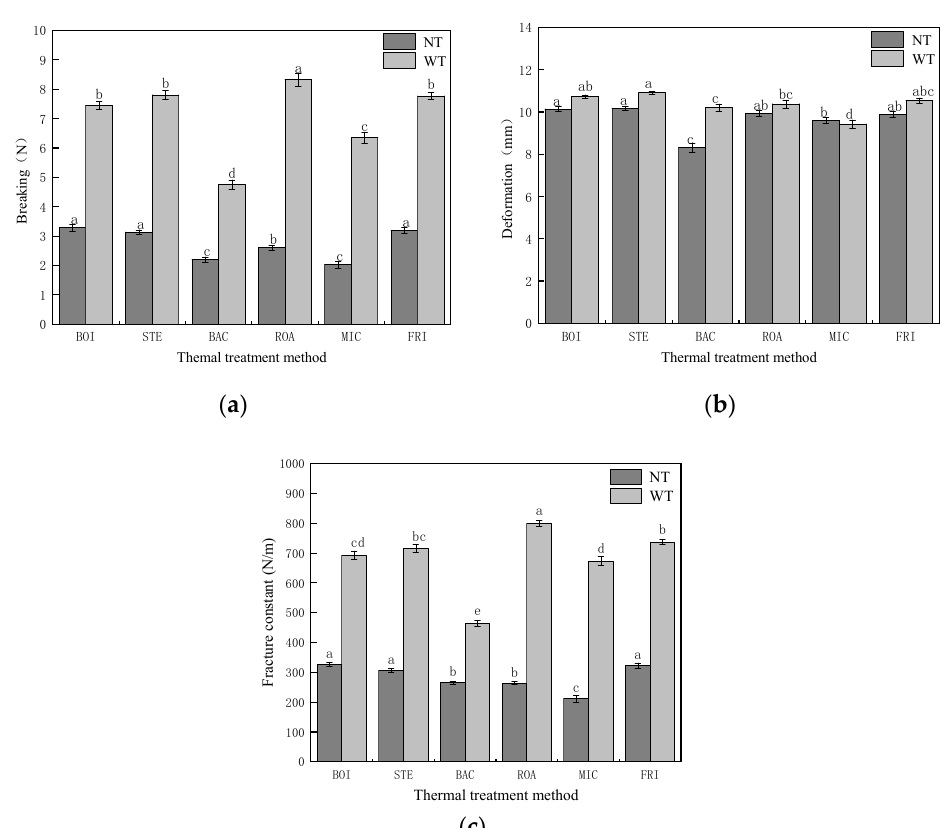
Figure 3. Effect of different thermal treatment methods and the addition of TGase on the fracture constant of D. maruadsi surimi products. ( a ): Breaking; ( b ): deformation; ( c ): fracture constant. BOI: boiled D. maruadsi surimi products; STE: steamed D. maruadsi surimi products; BAC: back-pressure sterilized D. maruadsi surimi products; ROA: roasted D. maruadsi surimi products; MIC: microwaved D. maruadsi surimi products; FRI: fried D. maruadsi surimi products; NT: group of without TGase; WT: group of with TGase. Completely different letters in the same indicator indicate significant differences between the same columns ( p <